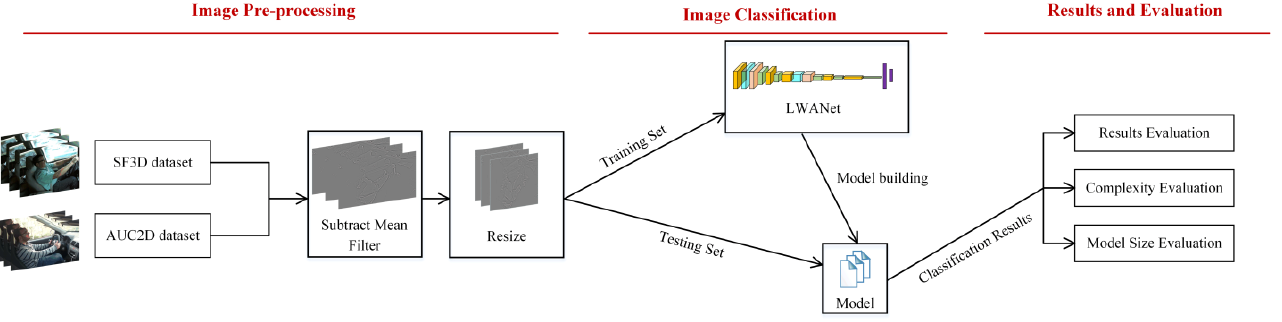
Figure 7. Overall flowchart.